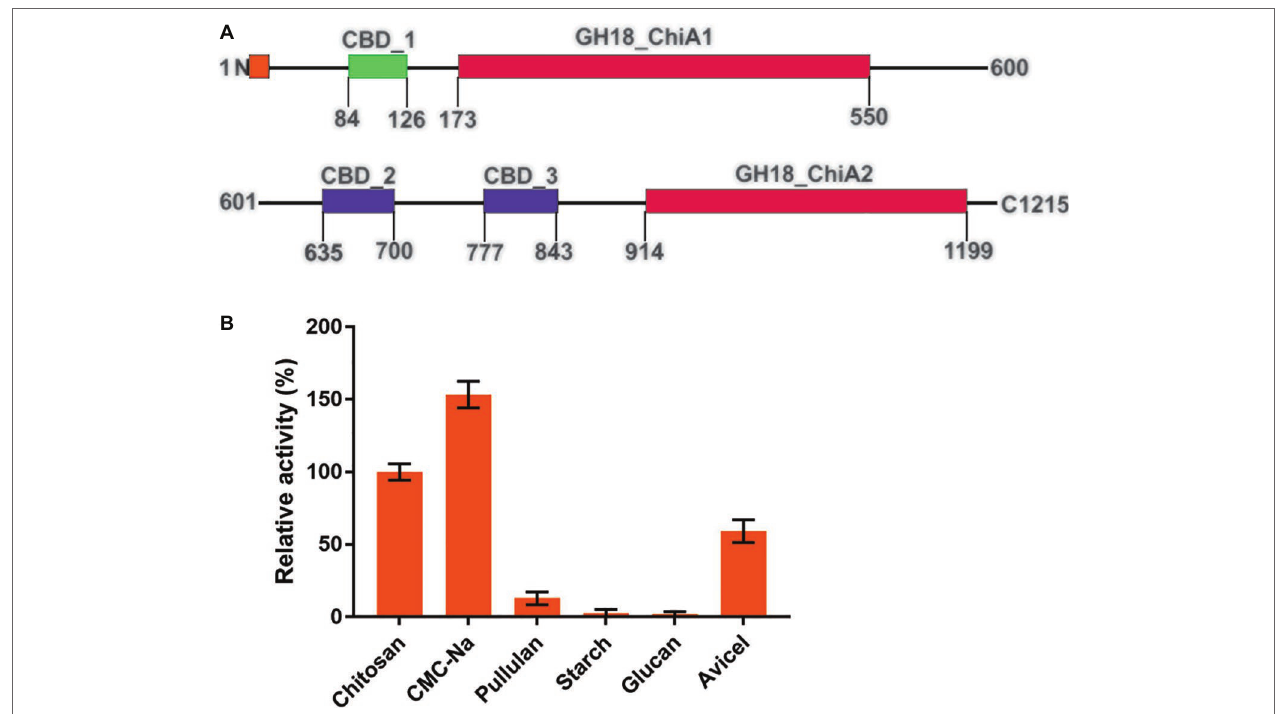
FIGURE 2 | Structural features of Tk-ChiA and the hydrolytic activity of the enzyme toward various substrates. (A) Domain architecture of Tk-ChiA. A putative signal sequence and the enzyme catalytic domains (GH18_ChiA1, 2) are shown in orange and red, respectively. The chitin-binding domain (CBD1) and chitin/cellulose-binding domains (CBD2, 3) are shown in green and purple, respectively. (B) Hydrolytic activity of Tk-ChiA for chitosan, CMC-Na, pullulan, starch, glucan and Avicel. The experiment was conducted in triplicate. Assays were performed as described in the section “Materials and